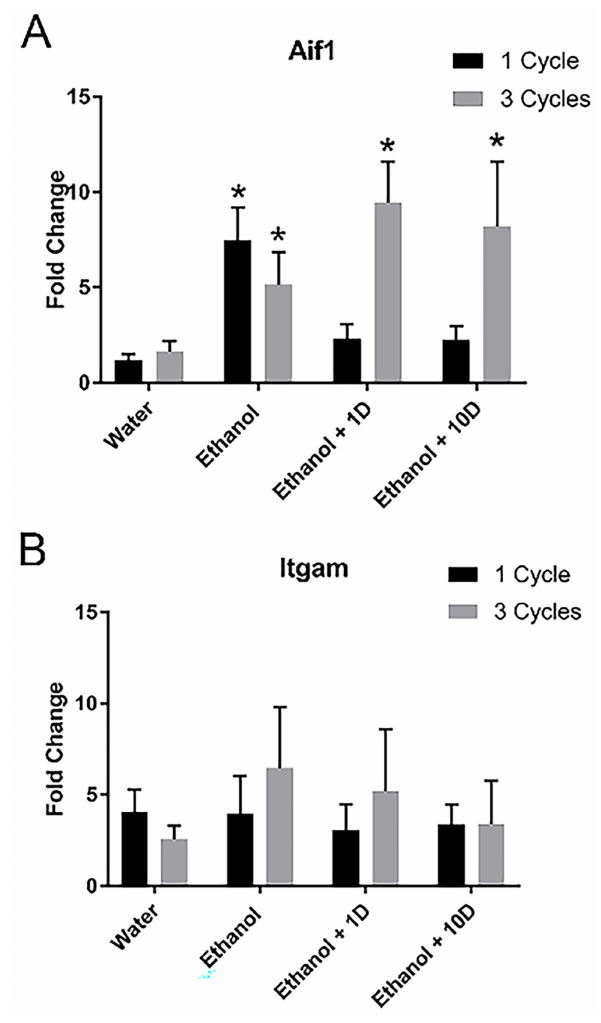
Fig. 5. Ethanol increases microglial mRNA . After both 1 and 3 weeks of ethanol, Aif-1 was significantly upregulated, but only after 3 weeks of ethanol exposure did the increase persist even 10 days after binge-like ethanol consumption (A). No significant changes were observed in Itgam expression (B). * p > 0.05 compared to